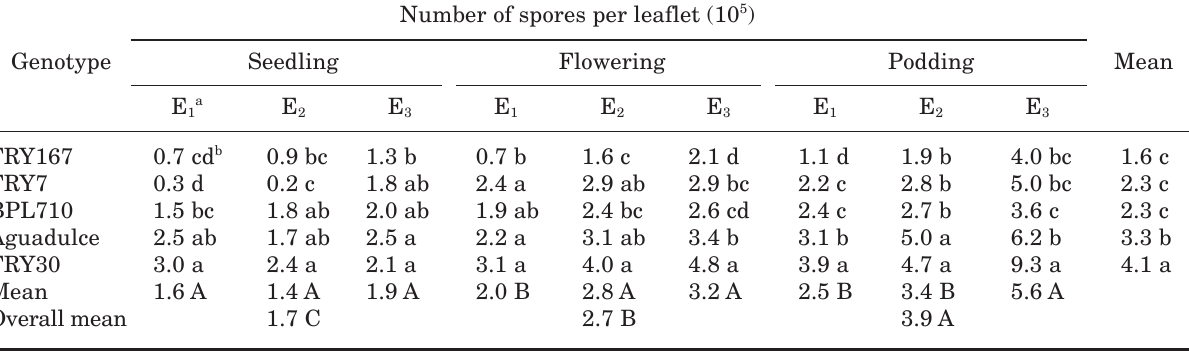
Table 3. Effect of growth stage and leaf age on number of spores per leaflet in leaflets of five faba bean genotypes inoculated with Botrytis fabae